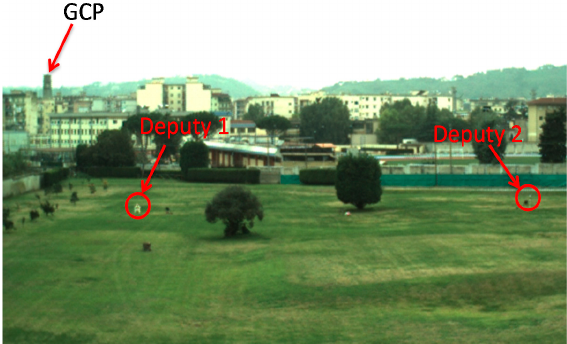
Figure 8. Example of flight image showing the observation geometry.